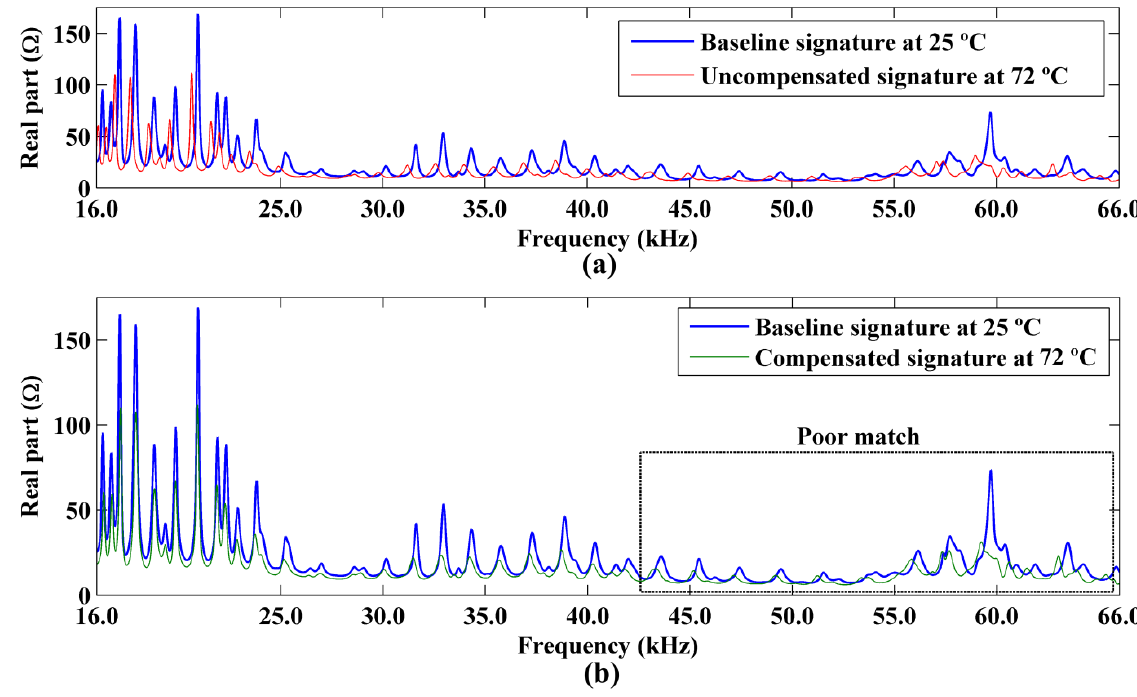
Figure 16. ( a ) Uncompensated and ( b ) compensated impedance signature obtained at 72 °C compared to the baseline signature at 25 °C using a wide frequency